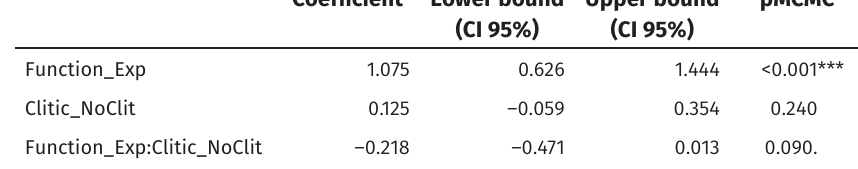
Table 1: Study 1 – Generalized linear mixed model fitted by using Markov chain Monte Carlo techniques (Hadfield 2010) with ordinal